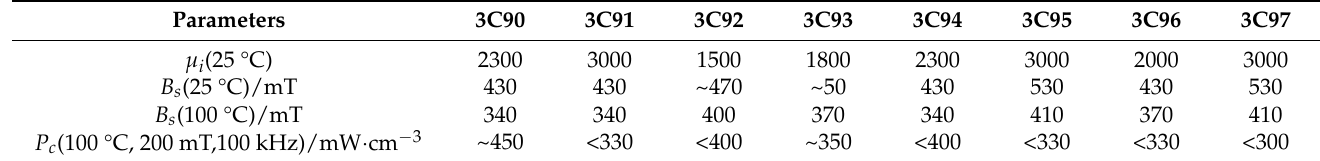
Table 6. Ferroxcube’s 3C series Mn-Zn ferrites product